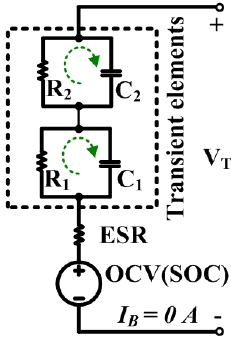
Figure 1. Electrical equivalent circuit model of the Li-ion battery (LIB).